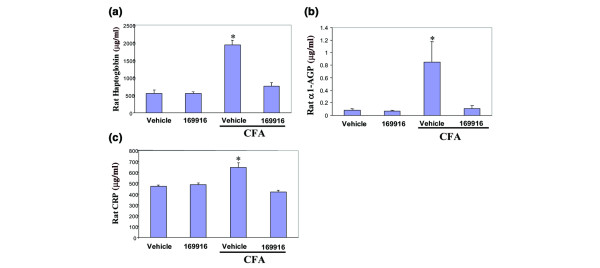
WAY-169916 inhibits the adjuvant-induced expression of serum acute-phase protein. Serum from control male rats or adjuvant-induced rats treated with either vehicle or WAY-169916 (5 mg/kg) was analyzed for the expression of (a) haptoglobin, (b) α1-acid glycoprotein (α1-AGP) or (c) C-reactive protein (CRP) by radial immunodiffusion assay. Results are expressed as means ± SEM from six rats per group. *P < 0.05 compared with vehicle control. CFA, complete Freund's adjuvant.